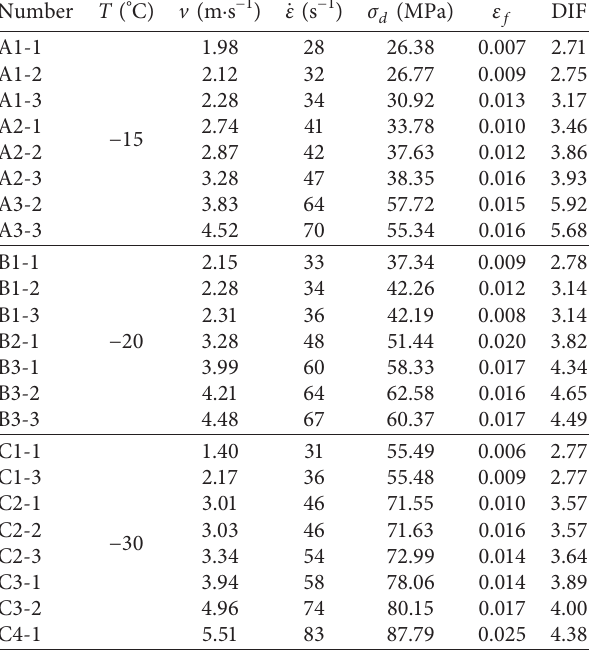
Table 3: Typical SHPB tests results.